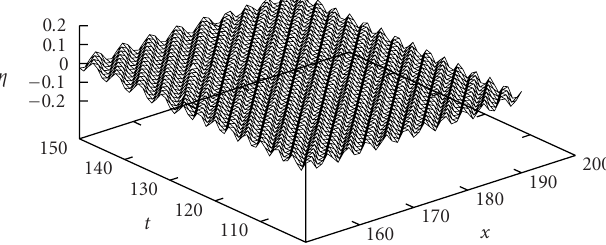
Figure 5.7. Wave motion due to initial displacement when t = 100 to 150, x = 150 to 200; (cid:1) = 0 . 01, D = 0 .